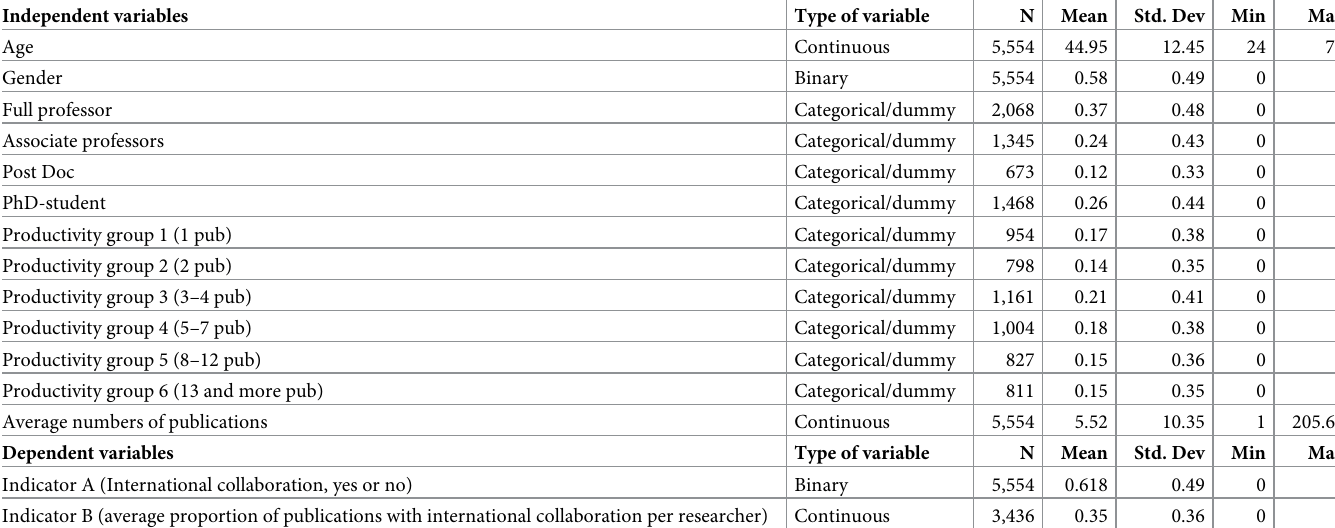
Table 2. Overview of the variables applied in the study with descriptive statistics.